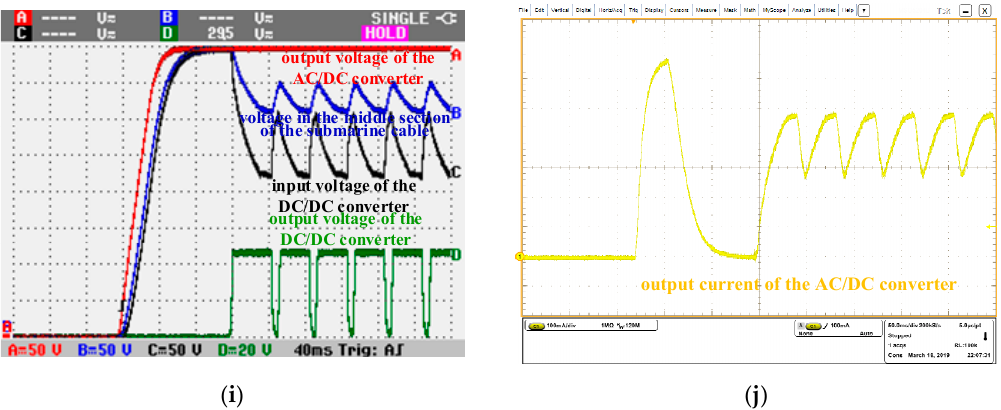
Figure 10. ( a ) The voltage transient processes in the parameter set #1; ( b ) the current transient